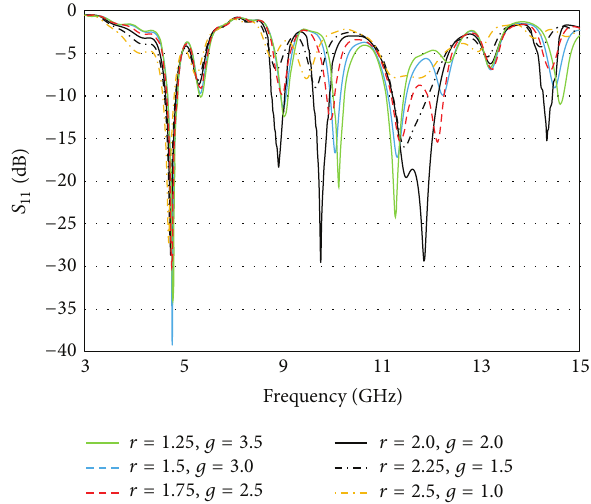
Figure 7: Variation of return loss characteristics with respect to the defect radius (𝑟) and gap between adjacent defects (𝑔)